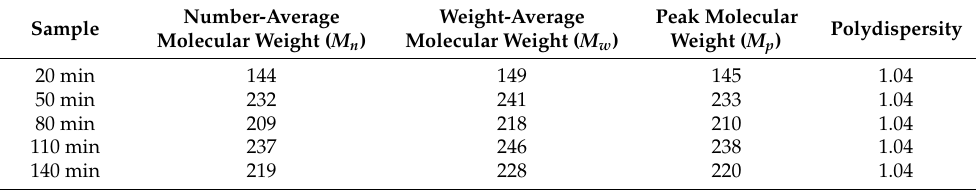
Table 4. The relative molecular weights of the liquefied products at different liquefaction times [95].